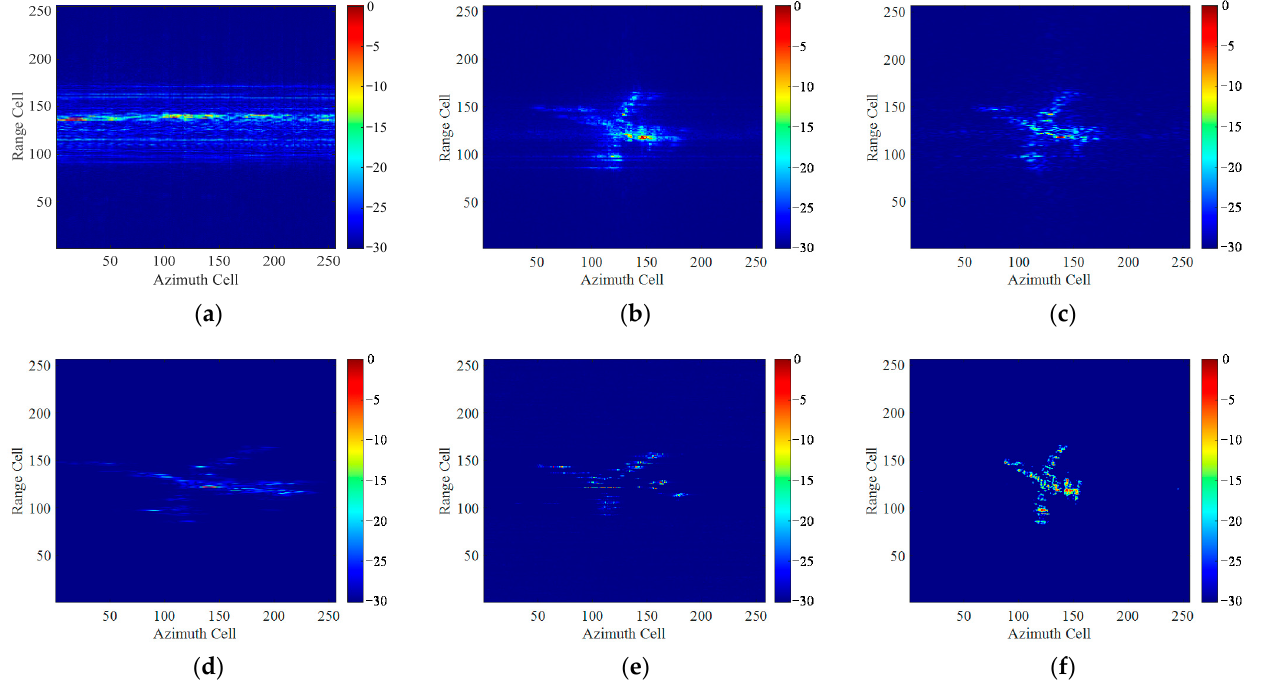
Figure 19. Imaging results of Yak-42 measured data under full aperture without noise by different methods: ( a ) echo after translational motion compensation; ( b ) RD algorithm; ( c ) STFT algorithm; ( d ) SPWVD algorithm; ( e ) RWT algorithm; ( f ) The proposed method.